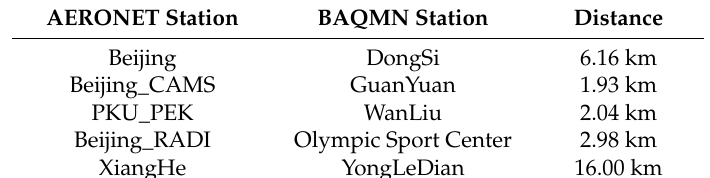
Table 1. The distance between paired stations.